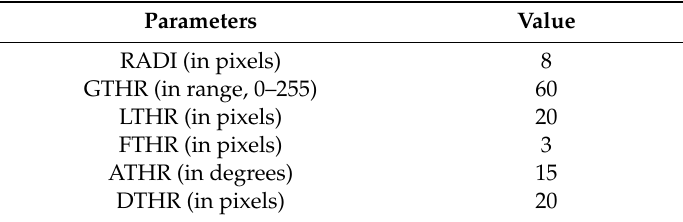
Table 3. Threshold parameters and values of lineament extraction [62].